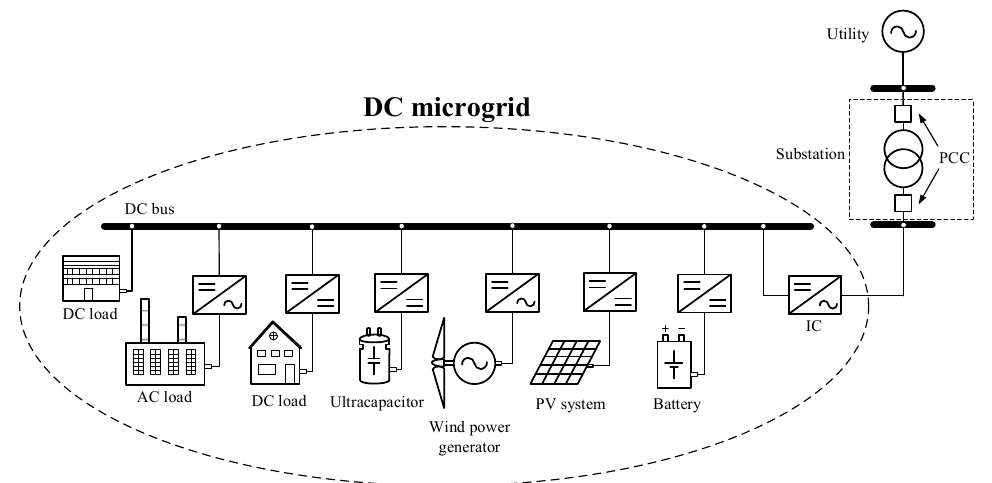
Figure 1. DC microgrid structure.